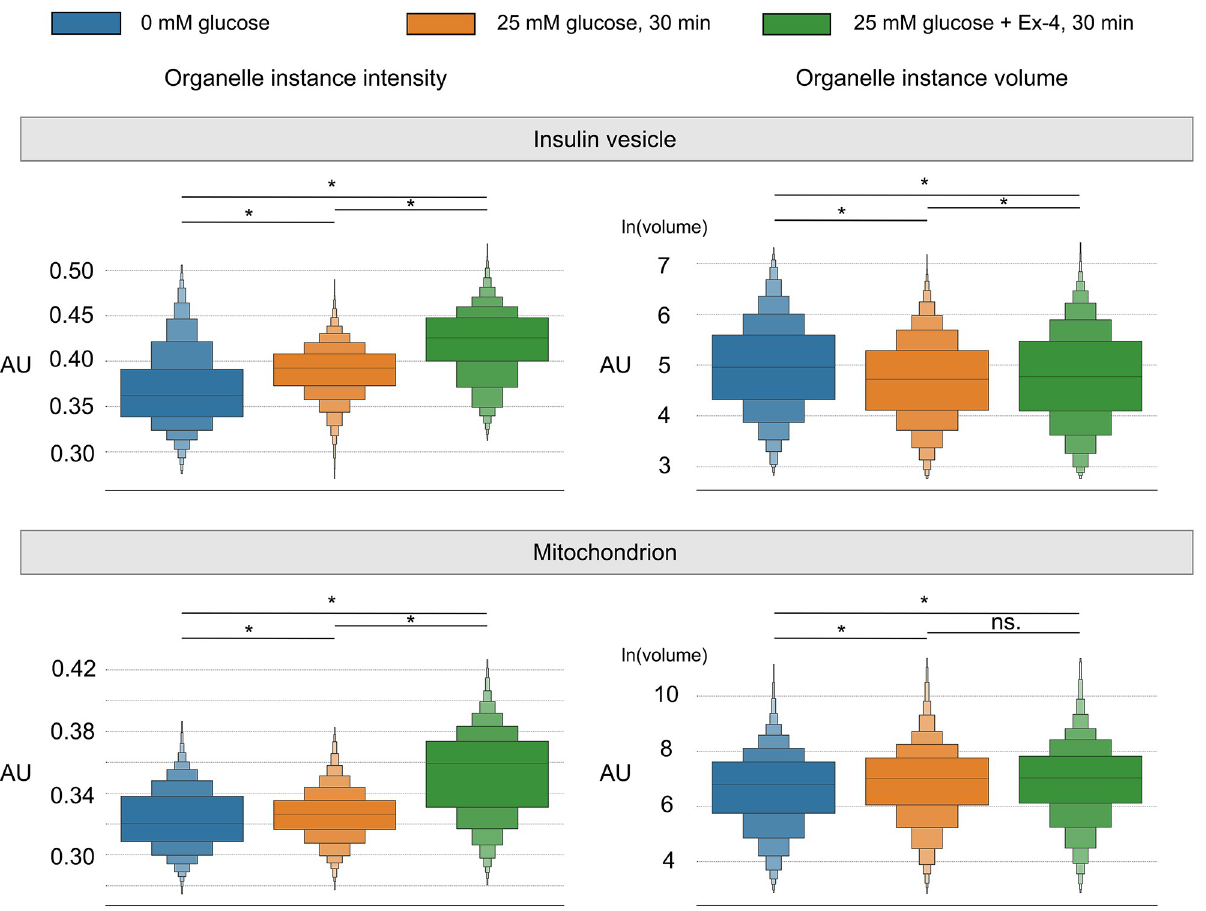
Fig 4. Analysis of insulin vesicle and mitochondria instances variance among conditions. Three conditions: 0 mM glucose, 25 mM glucose, 25 mM glucose + 10 nM Ex-4. Significance analysis are conveyed on Mann-whitney. � : p � 1.0 − 4 . AU: Arbitrary unit.